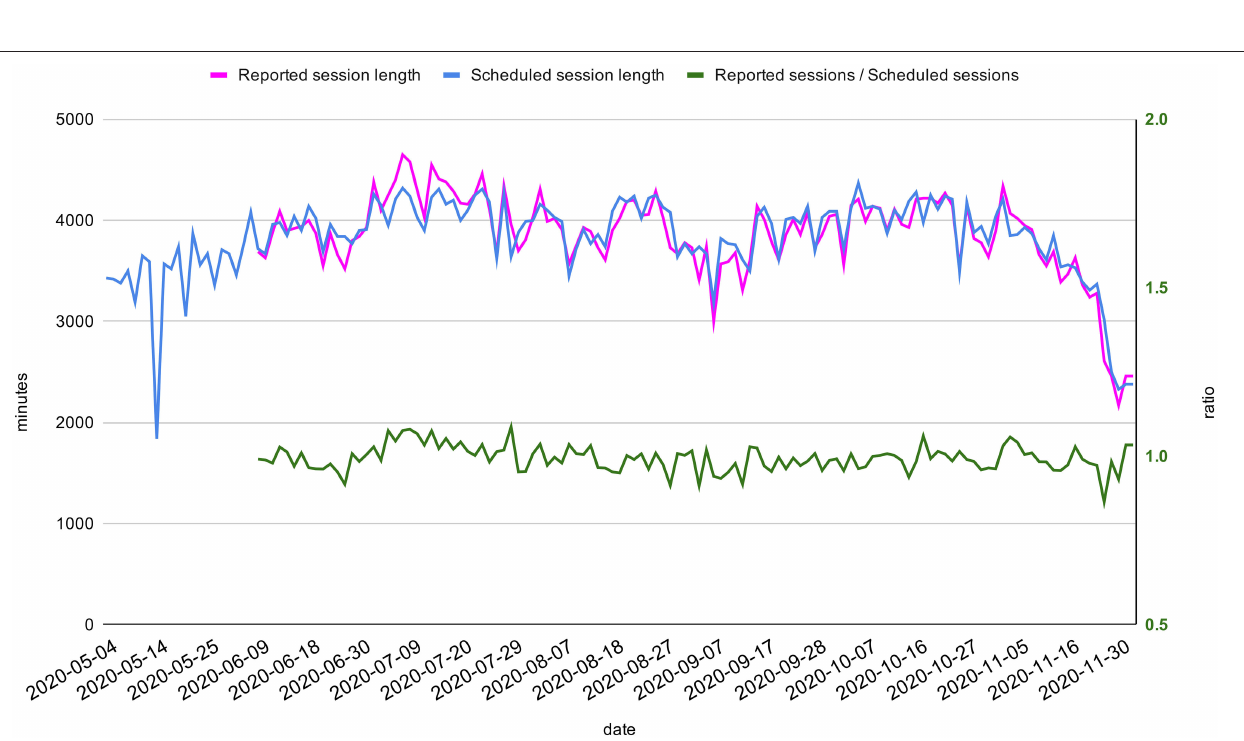
FIGURE 6 | Planned and reported sessions. Total daily minutes of planned and reported sessions between May 2020 and November 2020 (respectively pink and blue, on the left axis). The reporting activity has only started in June. The ratio between minutes of reported and planned sessions (green) is displayed on the right axis.